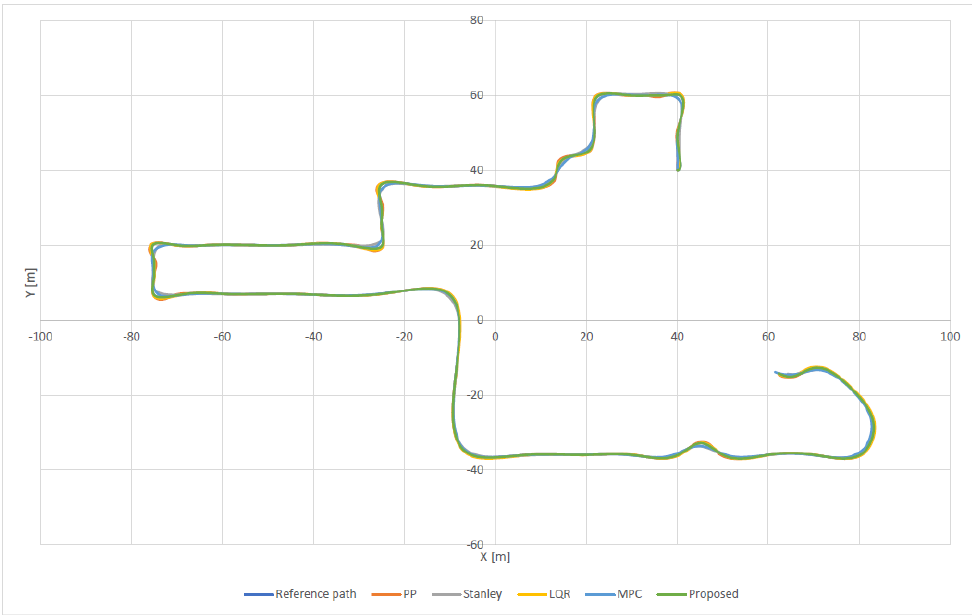
Figure 13. Reference UniSA trajectory (considered from the GPS) tracking performance comparison for different trajectory tracking controllers